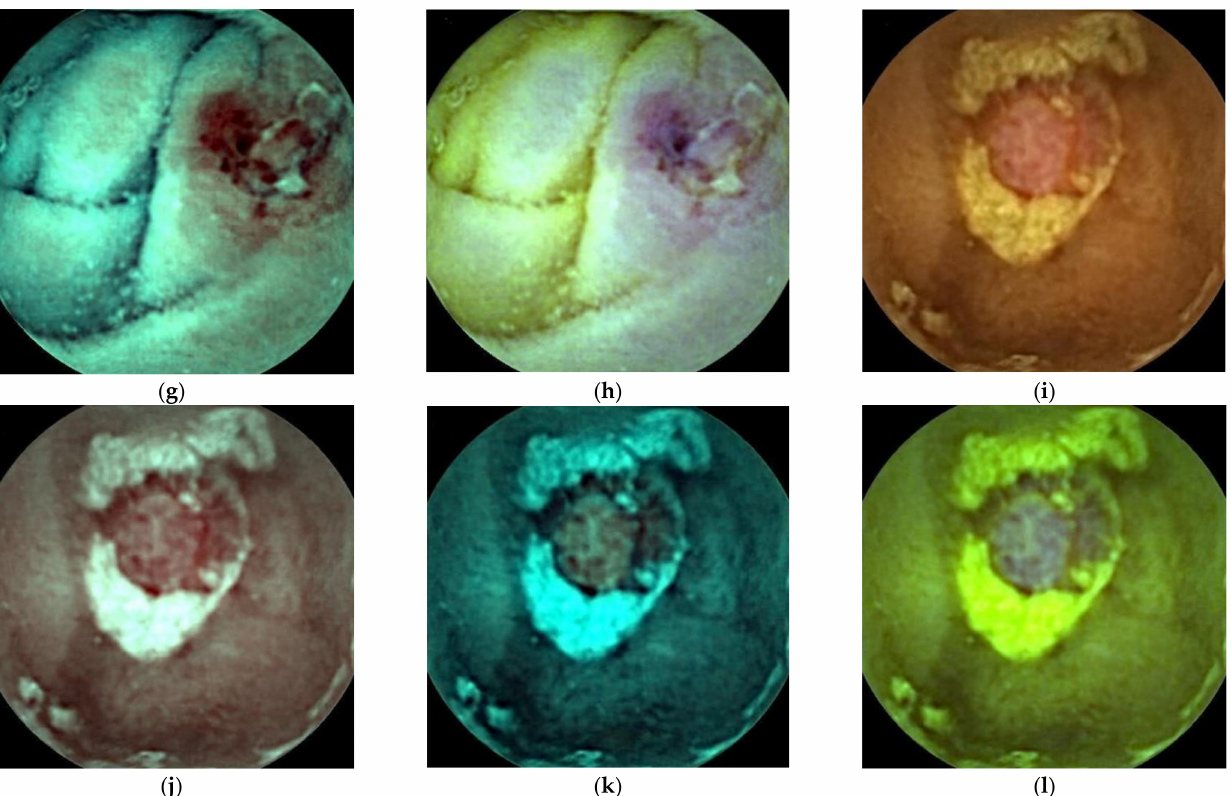
Figure 1. Capsule endoscopy images of small intestinal lesions; angioectasia ( a – d ), ulcer/erosion ( e – h ), tumor ( i – l ). WLI ( a , e , i ), FICE 1( b , f , j ), FICE 2 ( c , g , k ), FICE 3 ( d , h , l